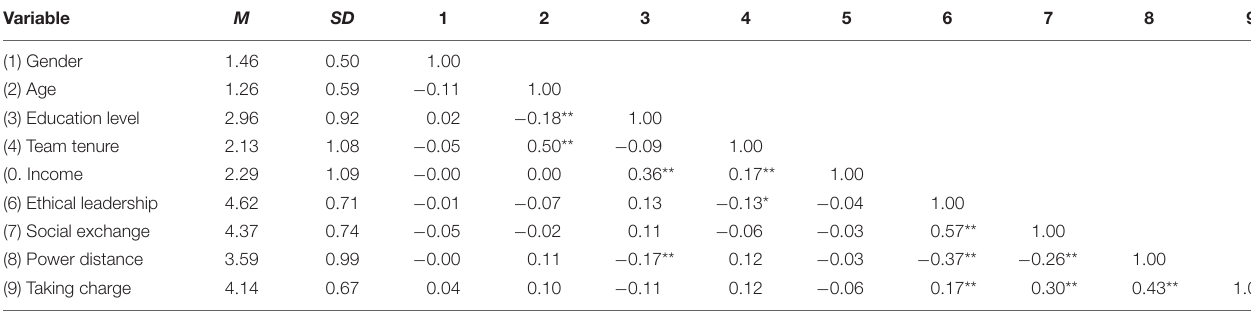
TABLE 3 | Means, standard deviations, and correlations.